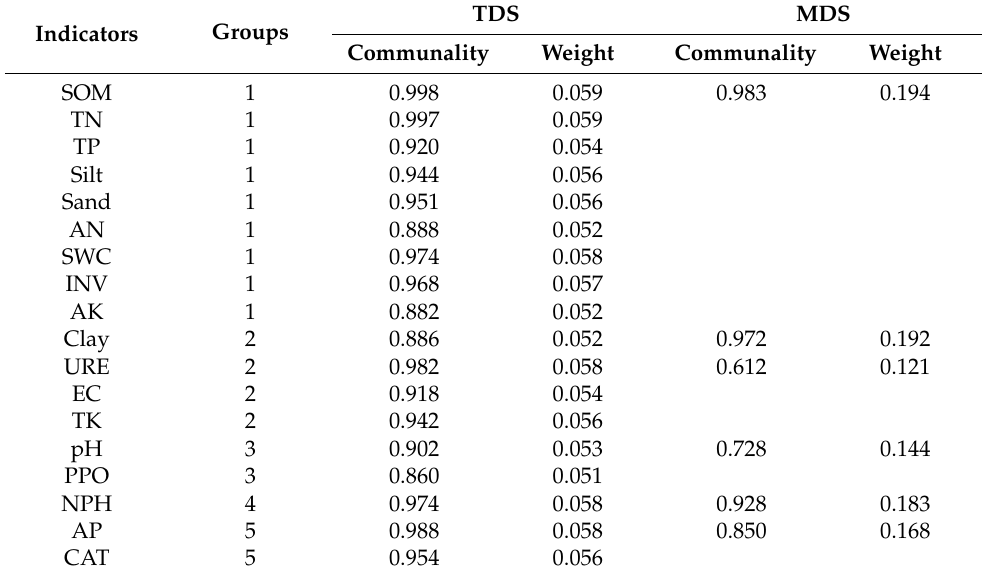
Table 4. Commonality and weight of the TDS and MDS.